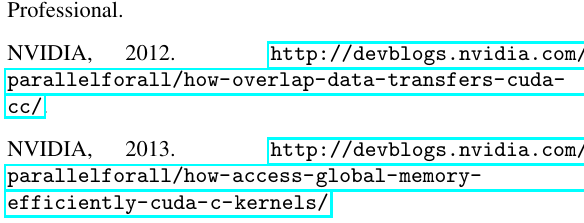
Figure 6. ST-Region GPU MapReduce with varying Time inter- val size (fixed dimension = 75 × 75